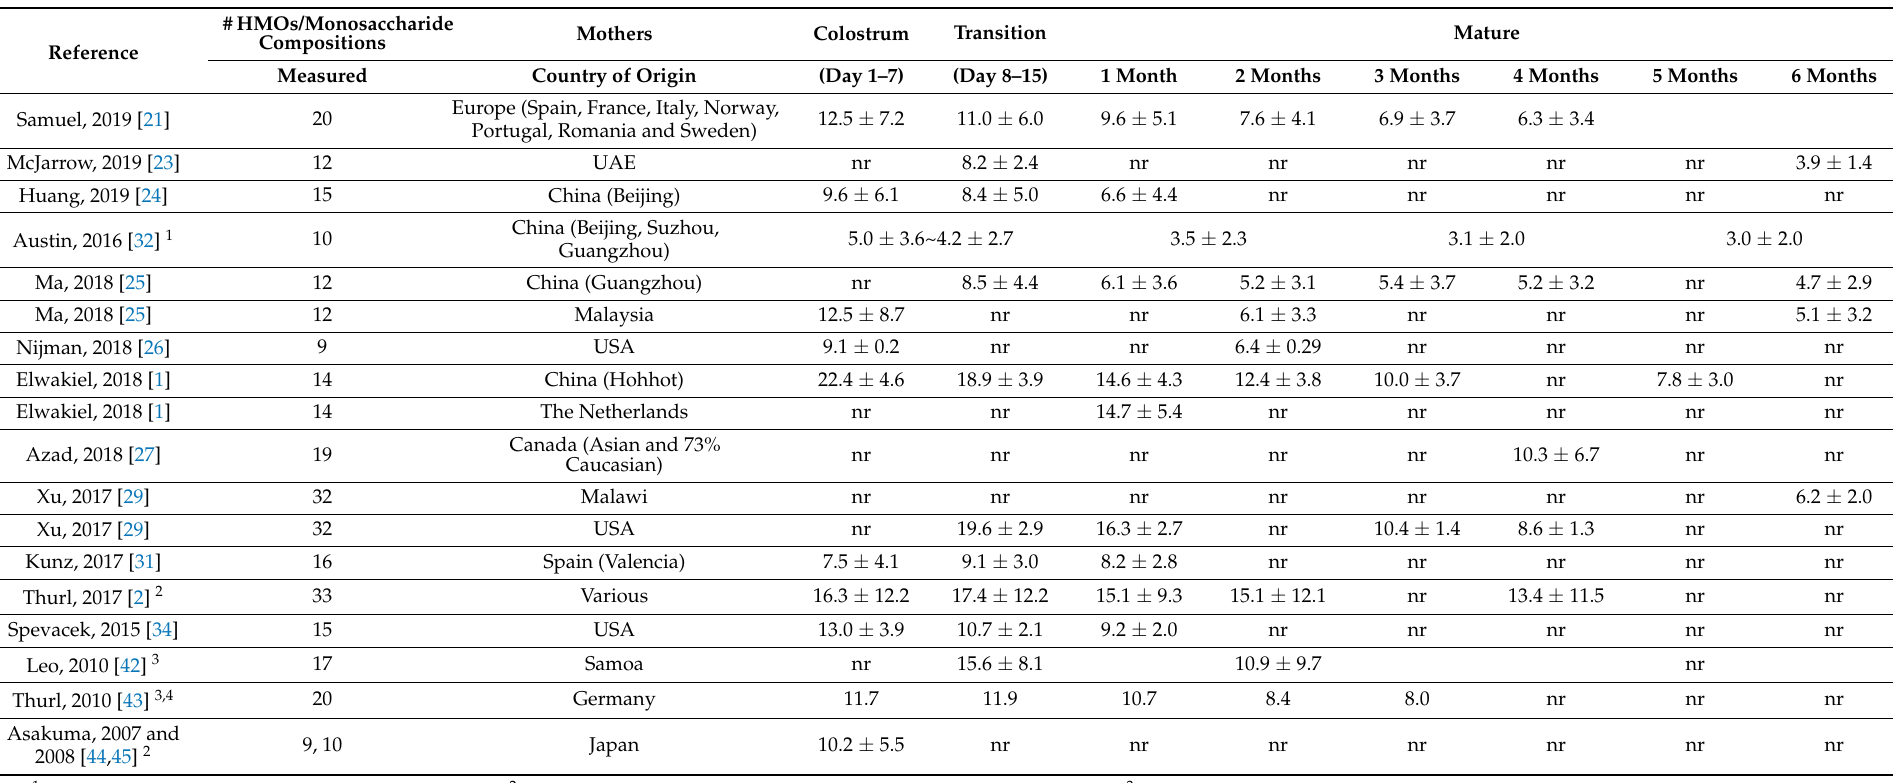
Table 3. Total HMO concentrations (g/L) in human colostrum, transitional, and mature milk from mothers with either positive or unknown secretor status. The concentrations of the HMOs were shown as mean ± standard